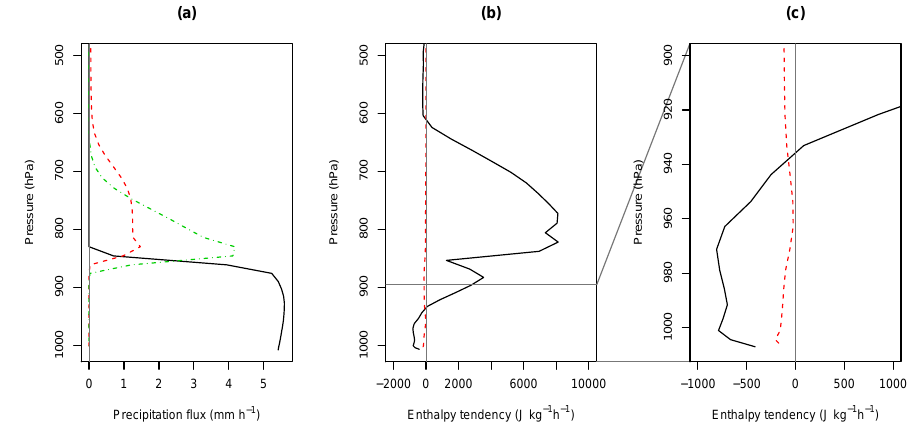
Figure 7. Vertical profiles at 18:00UTC in the point indicated in Fig. 6b for the run with the flux-conservative interface. (a) precipitation fluxes: rain (black solid line), snow (red dashed line), and graupel (green dash-dotted line); (b) cold-pool-generating phenomena: latent heat effects due to phase changes (black solid line) and sensible heat advection (red dashed line); (c) same as (b) but focused on near-surface